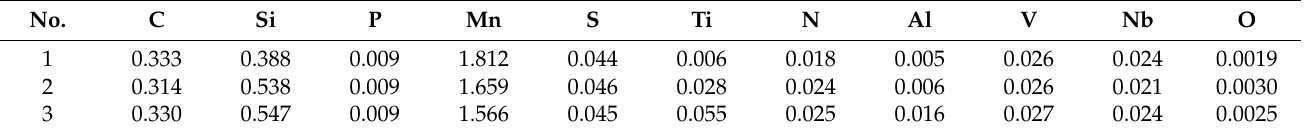
Table 1. Composition and element contents of non-quenched and tempered steel for test ( ω t%). No.